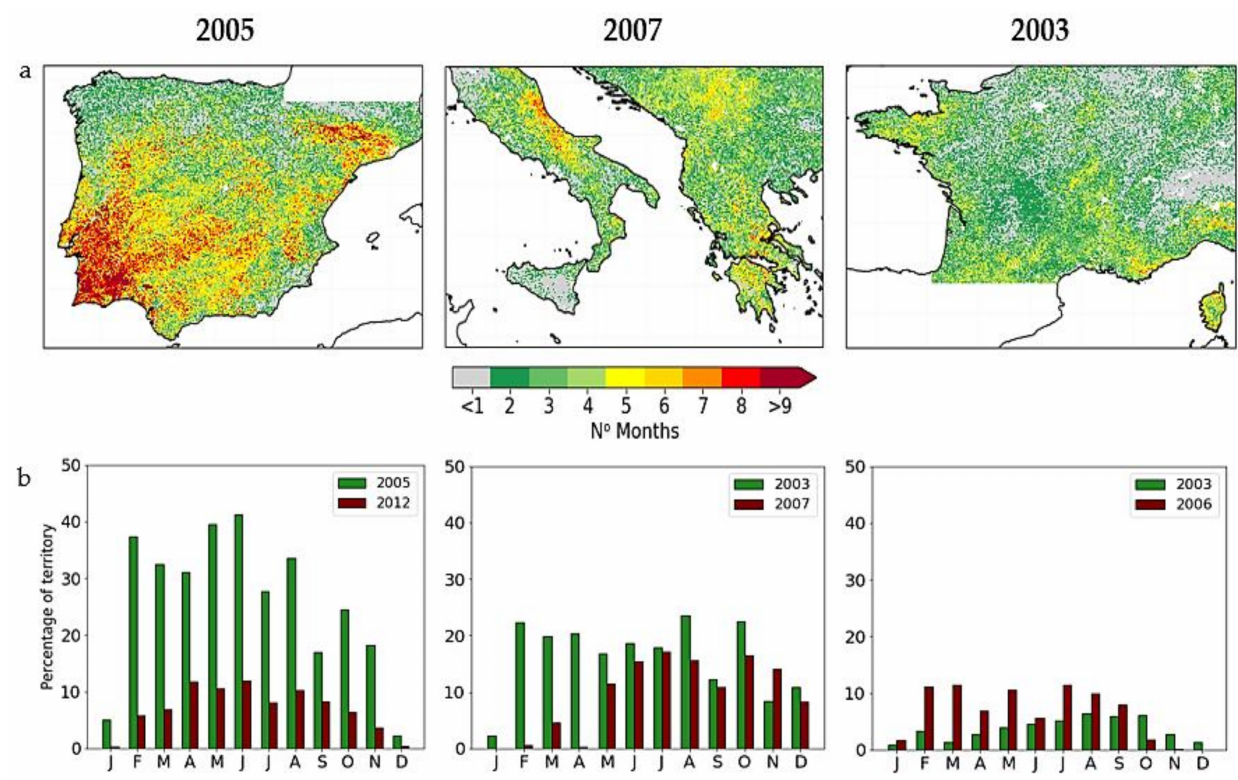
Figure 2. ( a ) Number of months whose pixels revealed GPP anomalies below the specific threshold in the study regions; ( b ) Percentage of territory with GPP anomalies lower than the specific monthly threshold for each selected